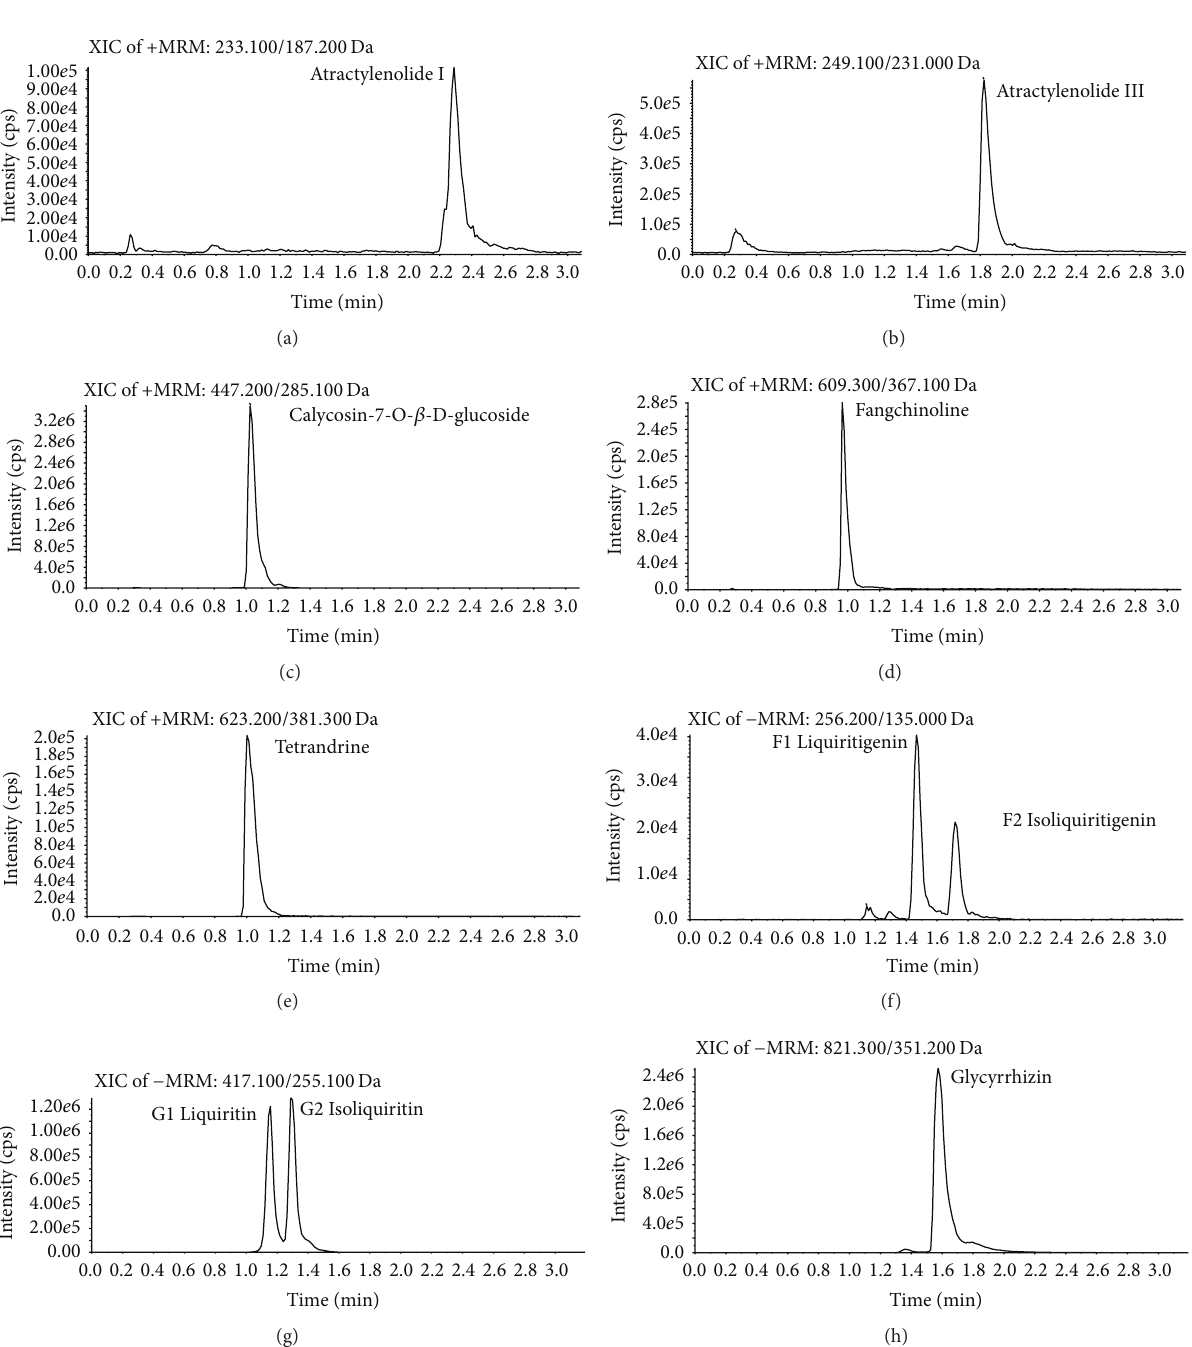
Figure 2: Representative extract ions chromatograms for the determination of the 10 analytes. (a) Atractylenolide I (2.28 min). (b) Atractylenolide III (1.83 min). (c) Calycosin-7-O- 𝛽 -D-glucoside (1.04min). (d) Fangchinoline (0.98 min). (e) Tetrandrine (1.01min). (f) Liquiritigenin (1.47 min) and isoliquiritigenin (1.72 min). (g) Liquiritin (1.17min) and isoliquiritin (1.31min). (h) Glycyrrhizin